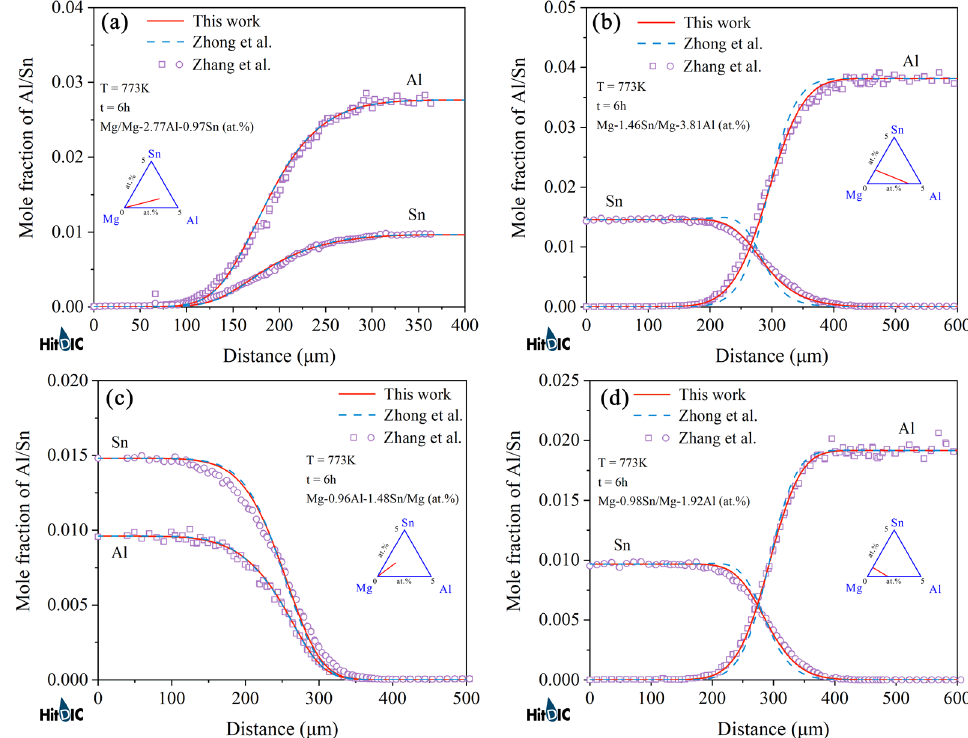
Figure 8. ( a – d ) Model-predicted composition–distance profiles of the different hcp Mg–Al–Sn diffusion couples annealed at 773 K for 6 h from the present atomic mobilities (solid lines) compared with those of Zhong et al. [32] (dashed lines) and the experimental data [34] (in symbols).